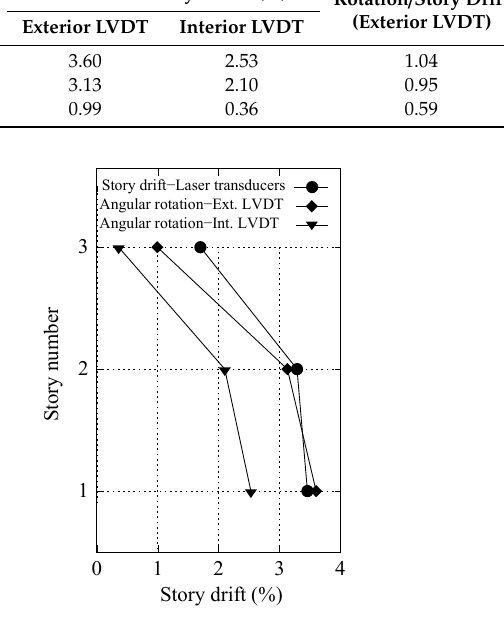
Figure 17. Story drift under the 160% design wave.